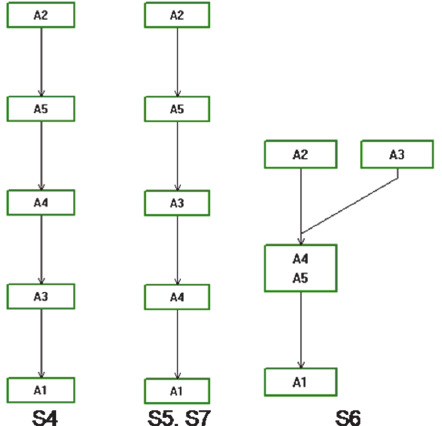
Fig. 5. Scenarios for variation of indifference and preference thresholds